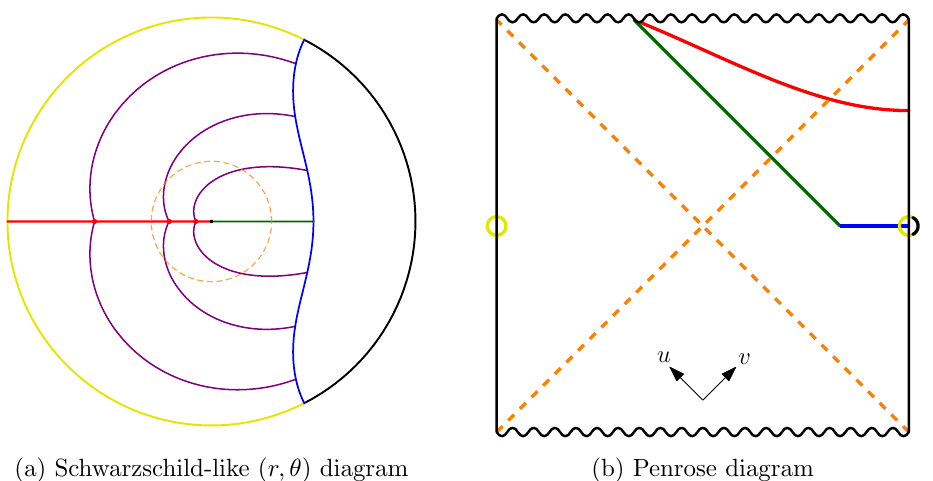
Figure 7. The red line represents the future caustic of a boundary region in the one- and two-sided BTZ black hole. The boundary region, shown in yellow, comprises more than half of the t = 0 slice of the right boundary and the complete left boundary time slice. The HRT surface is shown in blue and is chosen at r 0 = 1. A few representative orthogonal light rays are drawn in purple in (a) and meet at the caustic. The radial light ray reaching the singularity is shown in green. The horizon is chosen at R = 0 : 5 and is indicated in dashed